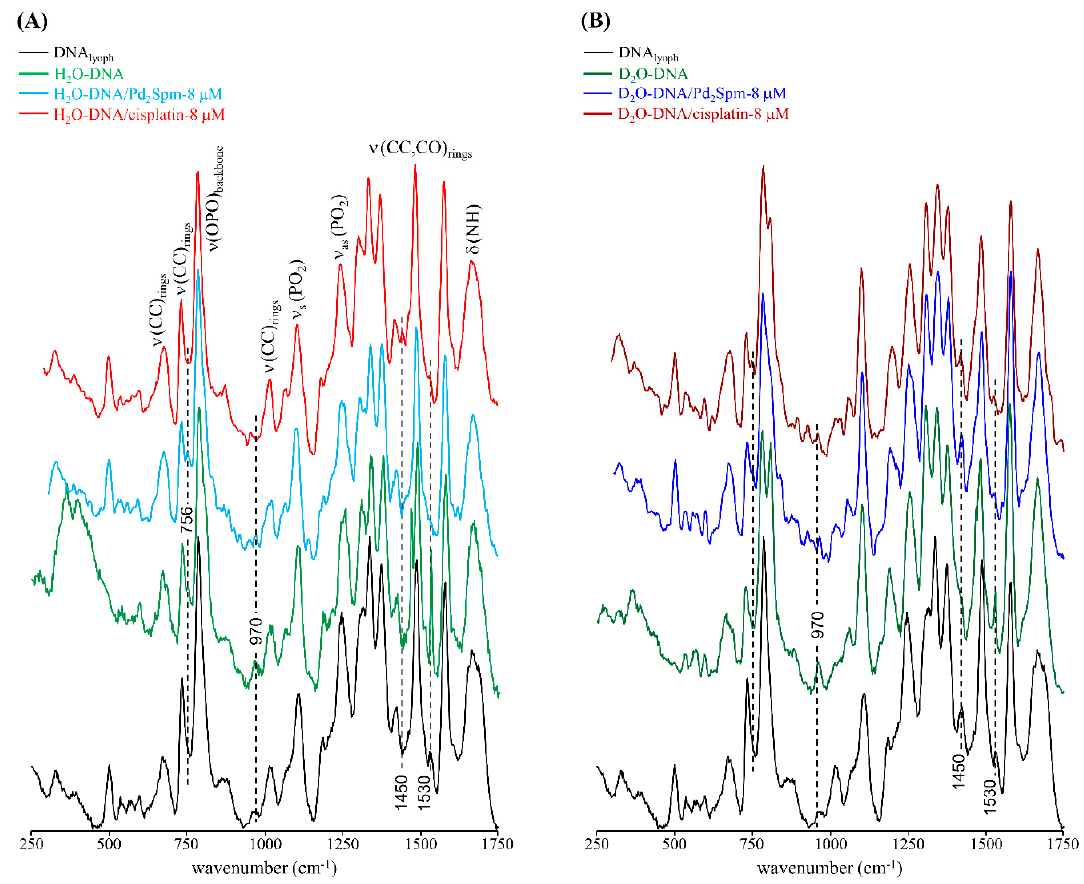
Figure 2. Raman spectra (250–1750 cm − 1 ) of DNA lyoph , H 2 O-DNA hyd ( A ) and D 2 O-DNA hyd ( B ), untreated and upon incubation (for 48 h) with cisplatin-8 µ M or Pd 2 Spm-8 µ M. (The main spectral changes are marked by dotted lines.)